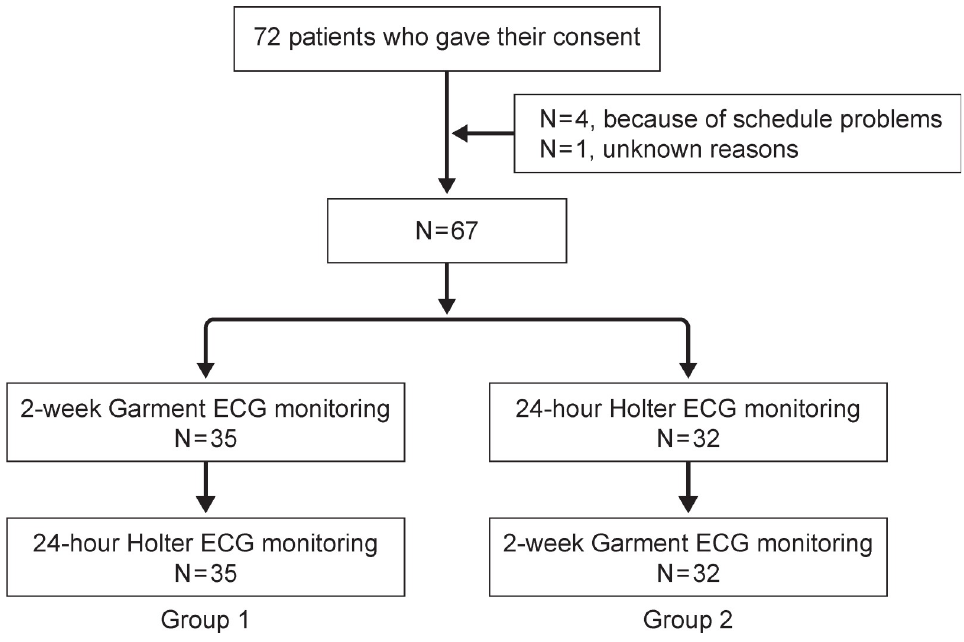
Fig 1. Patient flow diagram. ECG,